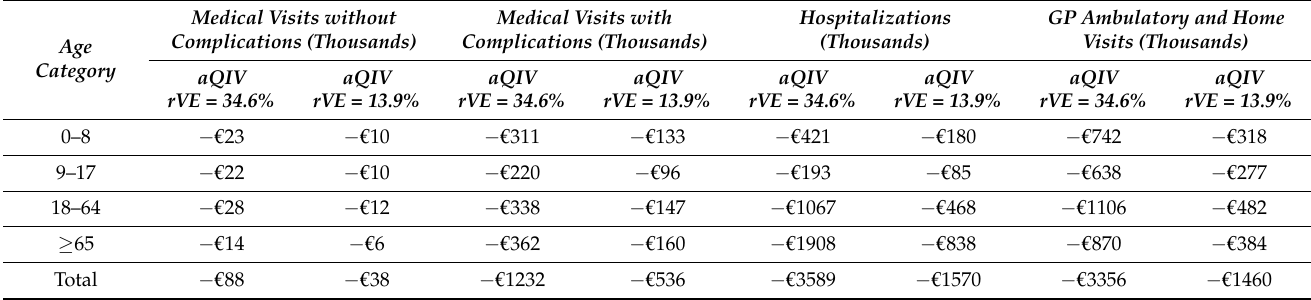
Table A1. Total (population) incremental direct medical costs.